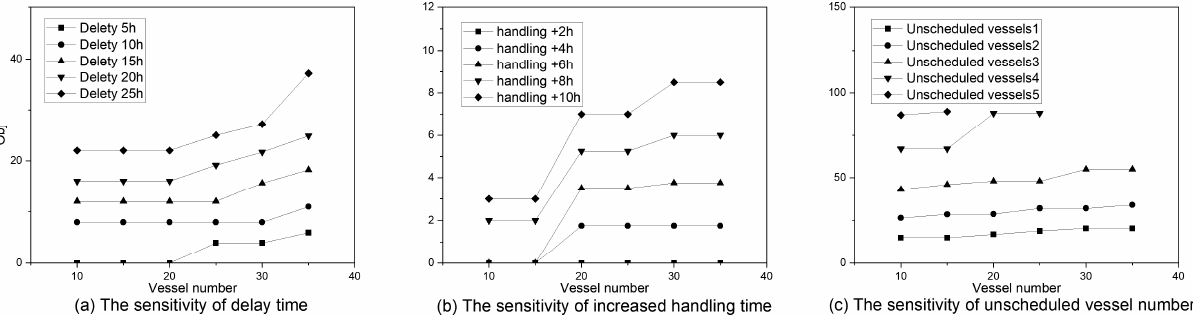
Figure 7. Sensitivity experiment results. ( a ) The sensitivity of delay time; ( b ) The sensitivity of increased handling time; ( c ) The sensitivity of unscheduled vessel number.